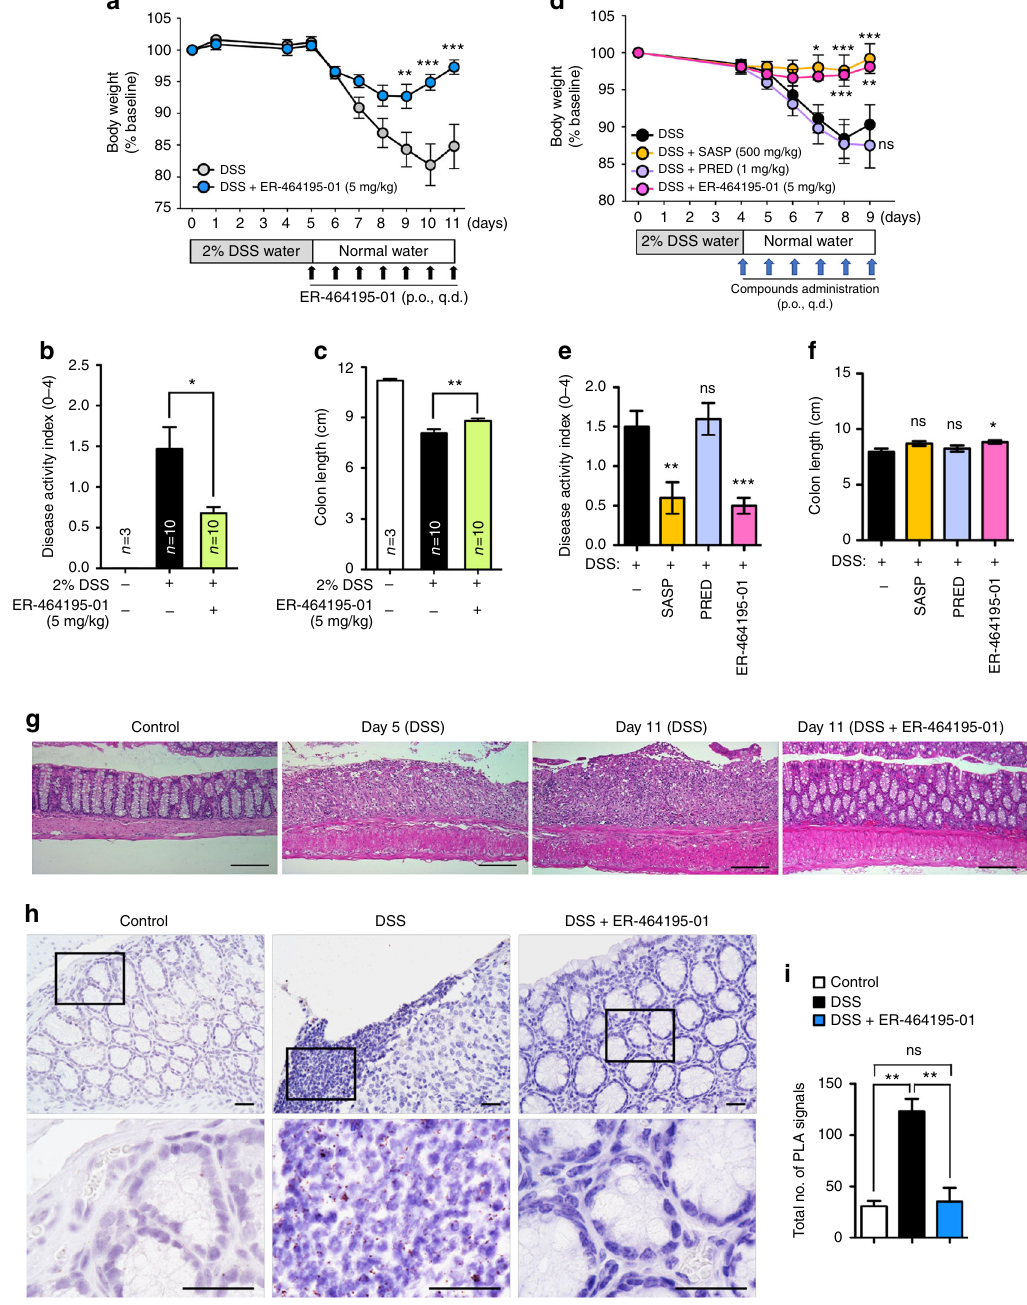
Fig. 4 ER-464195-01 has therapeutic effects against colitis of DSS-treated mice. a – c Improving colitis of DSS-treated mice in the therapeutic treatment with ER-464195-01 ( n = 10). Body weight a , DAI b , and colon length c . d – f Improving colitis of DSS-treated mice in the therapeutic treatment with sulfasalazine (SASP), prednisolone (PRED), or ER-464195-01 ( n = 12). Results are given as the mean ± SEM of the number of animals; * P < 0.05, ** P < 0.01 and *** P < 0.001 vs. DSS alone group (two-way ANOVA followed by Bonferroni ’ s post test) a, d , and * P < 0.05, ** P < 0.01, and *** P < 0.001; SASP, PRED, or ER-464195-01-treated group vs. DSS-treated group at day 11 b , c , or at day 9 e , f (two-tailed t test). g Hematoxylin and eosin staining for DSS-mediated histological changes. Scale bars, 100 μ m. h In situ PLA assay for the interaction of CRT with ITGA4 at the mucosa for DSS-mediated histological changes in mice. Bottom panels; enlarged boxes. Scale bars, 20 μ m. i Quantitative analysis of h . Results are given as mean ± SEM of n = 3; ** P < 0.01 and ns (not signi fi cant). Statistical signi fi cance was evaluated using one-way ANOVA with Bonferroni ’ s multiple comparison